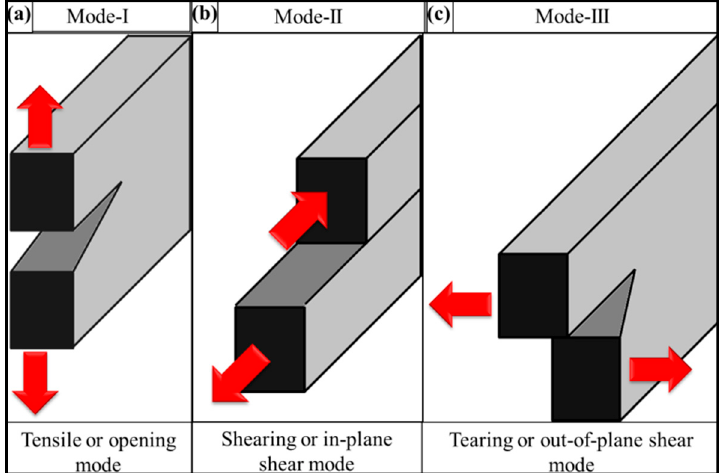
Figure 2. Various fracture modes: ( a ) mode-I, ( b ) mode-II, and ( c ) mode-III.